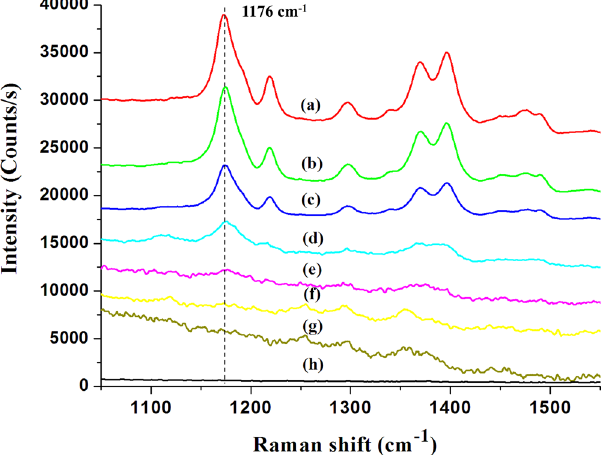
Figure 4. Raman spectrums of MG with various concentrations measured by optimized SERS substrate. The labeled represented different concentrations of MG as following ( a ) 10 mM, ( b ) 1 mM, ( c ) 100 μ M, ( d ) 10 μ M,